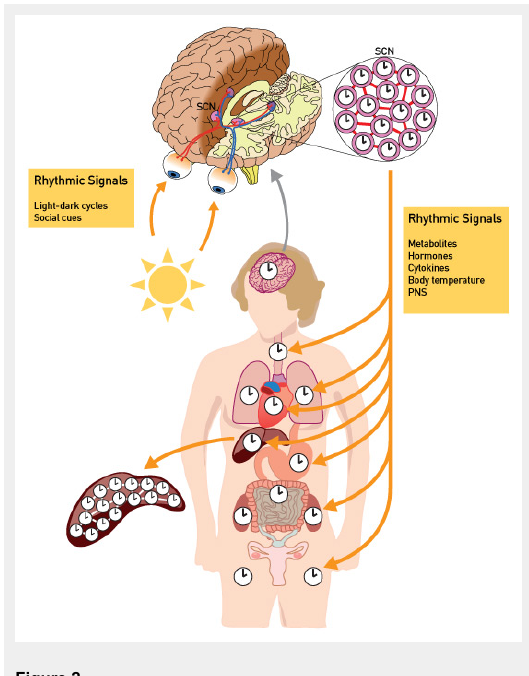
the molecular makeup depicted in figure 1. The suprachiasmatic nucleus (SCN) harbours the central clock, which is responsible for all overt rhythms in behaviour and physiology. It is composed of two tiny agglomerates of neurones, whose oscillators are coupled through synaptic and paracrine signalling mechanisms (represented as red lines connecting the clock neurones). The phase of the SCN is adjusted to geophysical time every day by light signals perceived in the retina. The clocks in peripheral cell types are synchronised by the SCN through a variety of systemic signals, including metabolites (e.g. nicotinamide adenine dinucleotides), hormones (e.g. cortisol), cytokines (e.g. transforming growth factor- β), body temperature, and neuronal signals from the peripheral nervous system. In the liver, the phases of oscillators remain coupled even in the absence of systemic signals from the